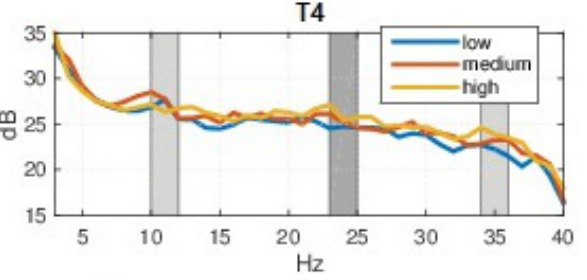
Figure 10. GA Spectrum for Nat images on 3 complexity levels according to CFD, at T4